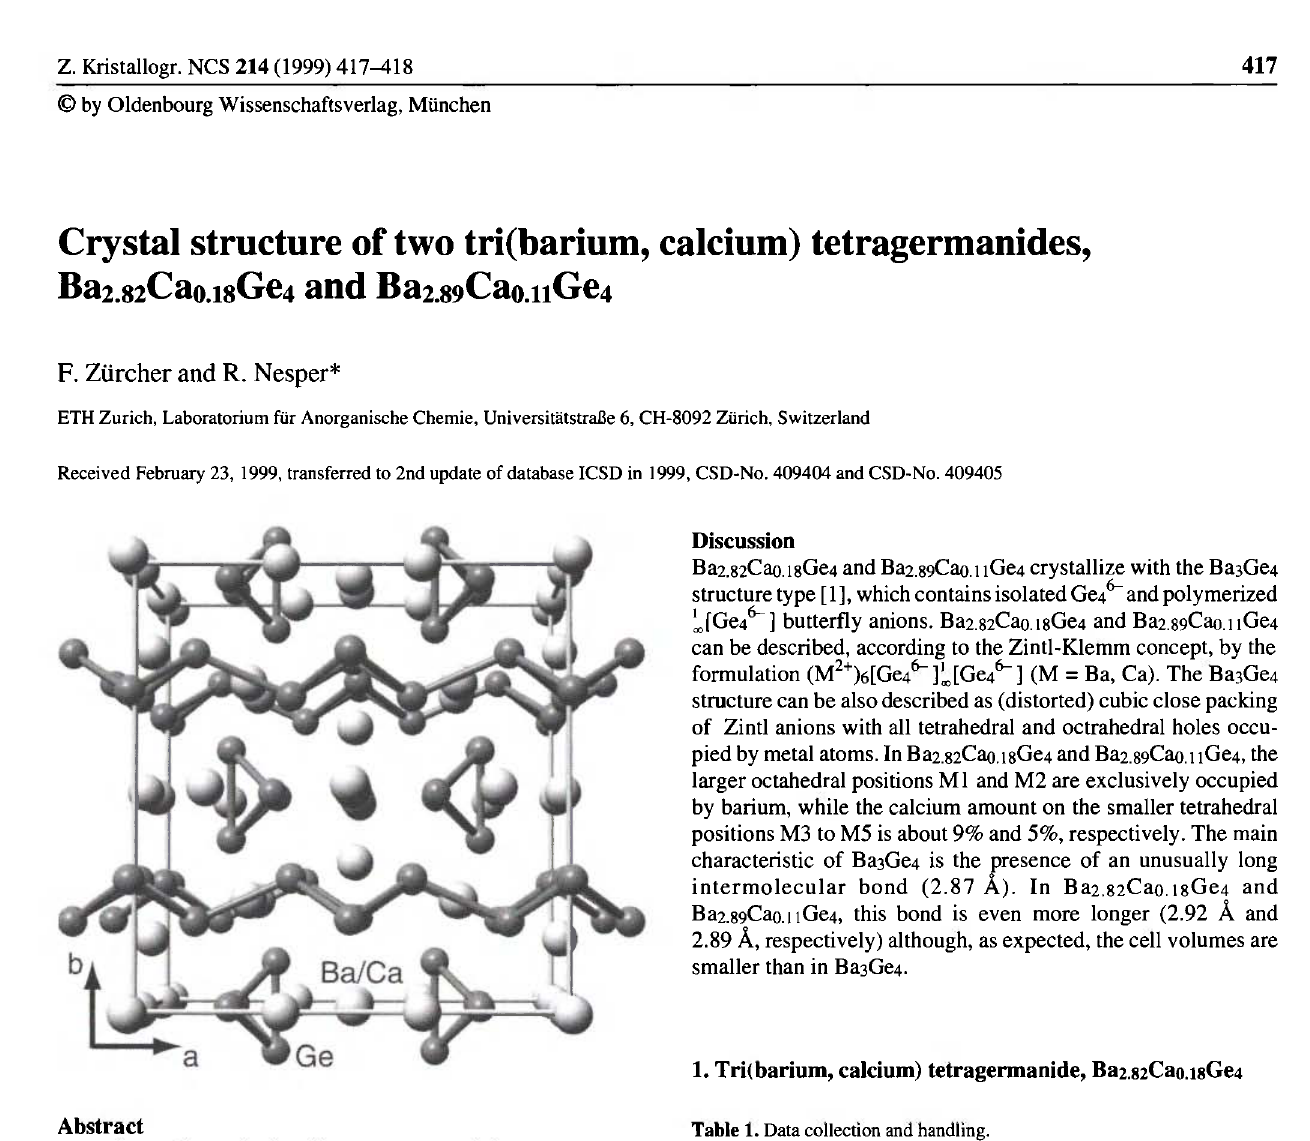
Table 1. Data collection and